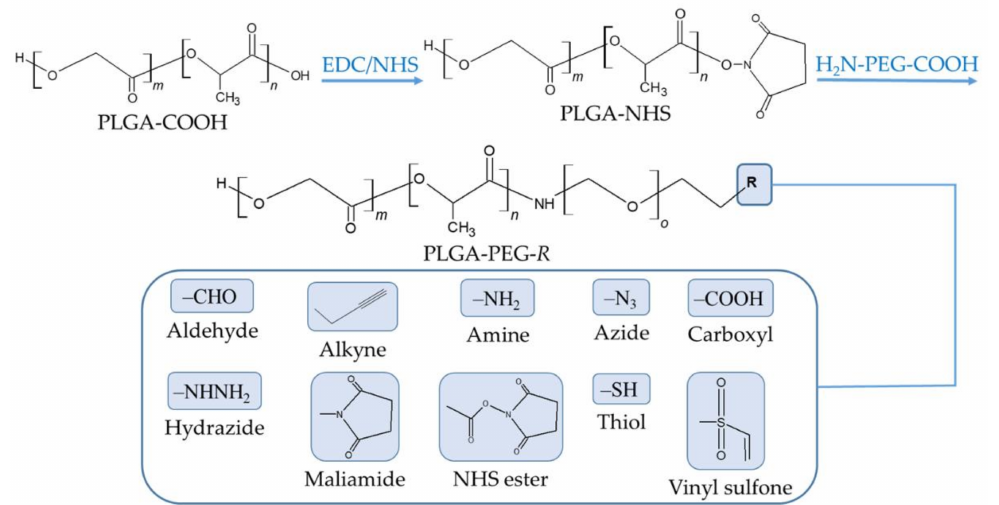
Figure 4. Schematic representation of the synthesis of a PLGA-PEG conjugate using a carbodiimide coupling reaction. The conjugate can be further functionalized using PEG derivatives with various terminal